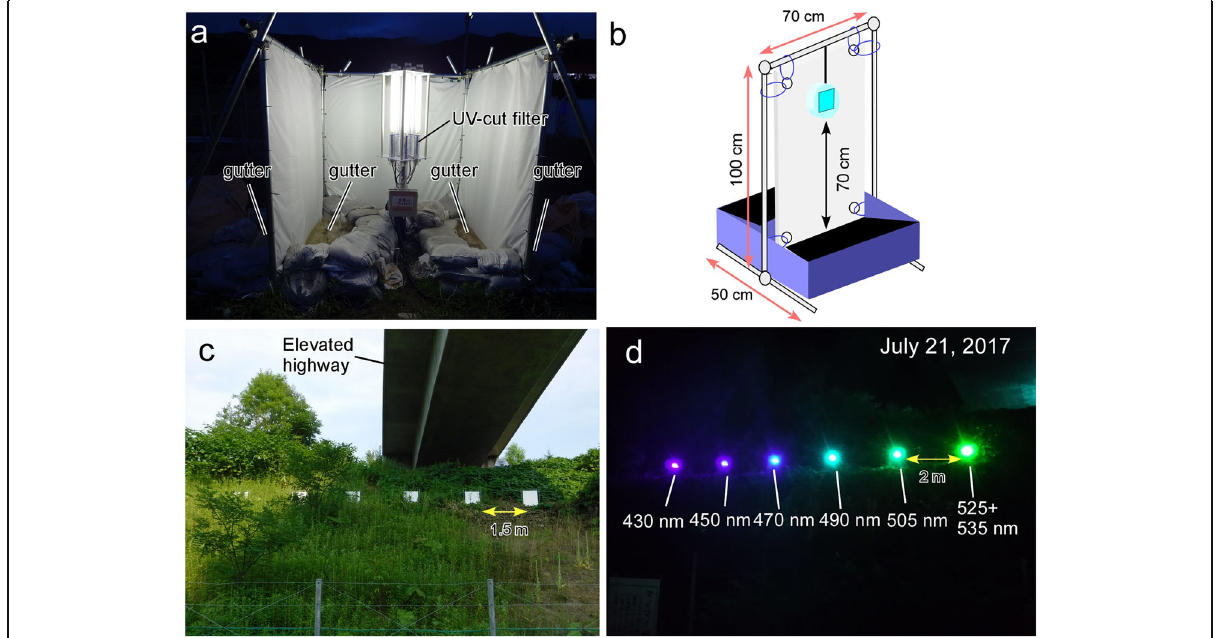
Fig. 3 Configurations of light traps used in the field experiments. a “ Light tower ” trap used in 2014 and 2015. See Additional file 2 for details. b Flight-interception LED traps used in 2017 and 2018. See additional file 3 for details. Six flight-interception LED traps that emitted light with different light wavelengths ( d ) were set on a hill on flat ground beneath an elevated expressway ( c ). The intensity of total illumination for each LED module was adjusted to approximately 1500 lm ( d